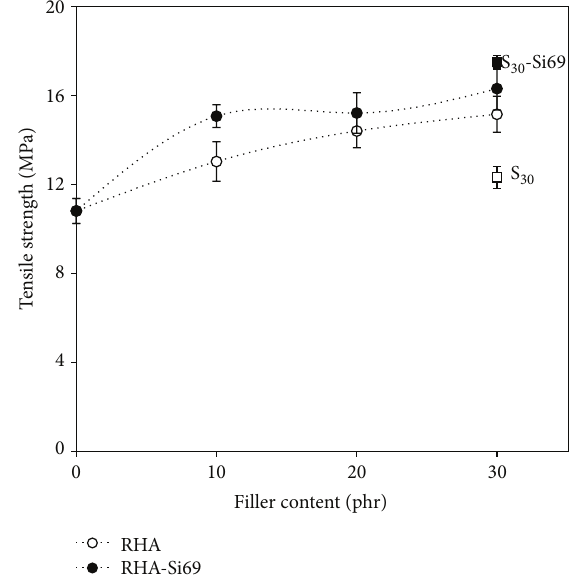
Figure 6: Young’s modulus of gum and filled ENR-25 vulcanizates with various RHA contents and 30 phr of silica with and without silane coupling agent (Si69).